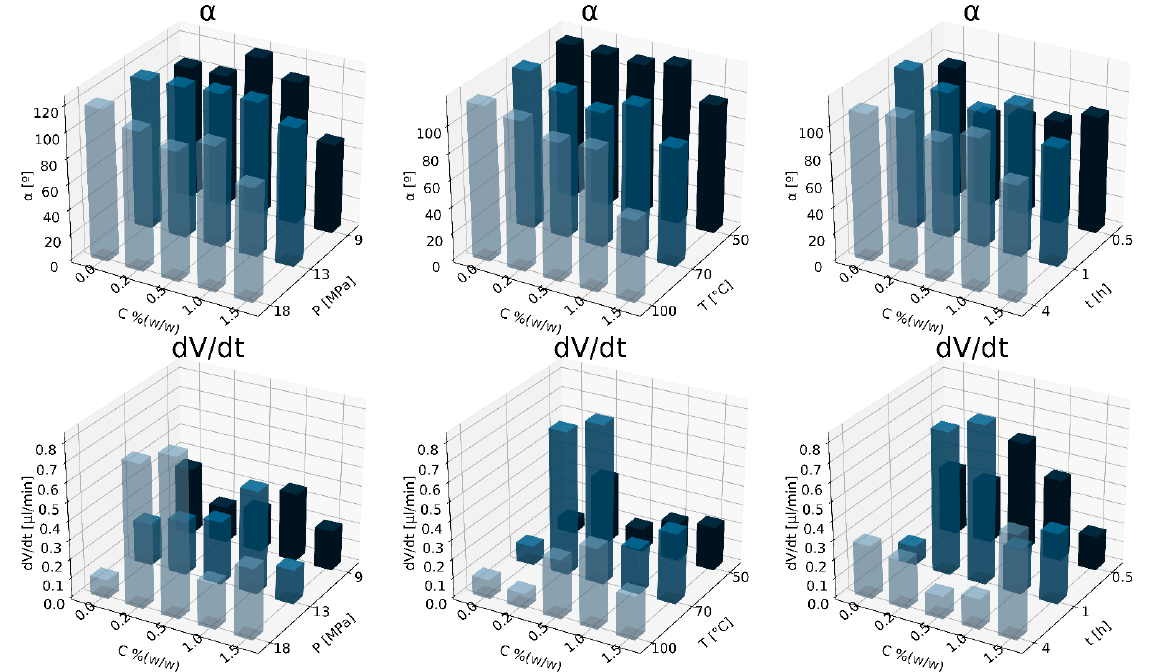
Figure 6. Influence of nGO concentration for variable conditions of the foaming process: pressure P sat (9–18 MPa), T sat (50–100 °C) and saturation time t sat (0.5–4 h) on the contact angle ( α ), absorption rate (dV/dt).